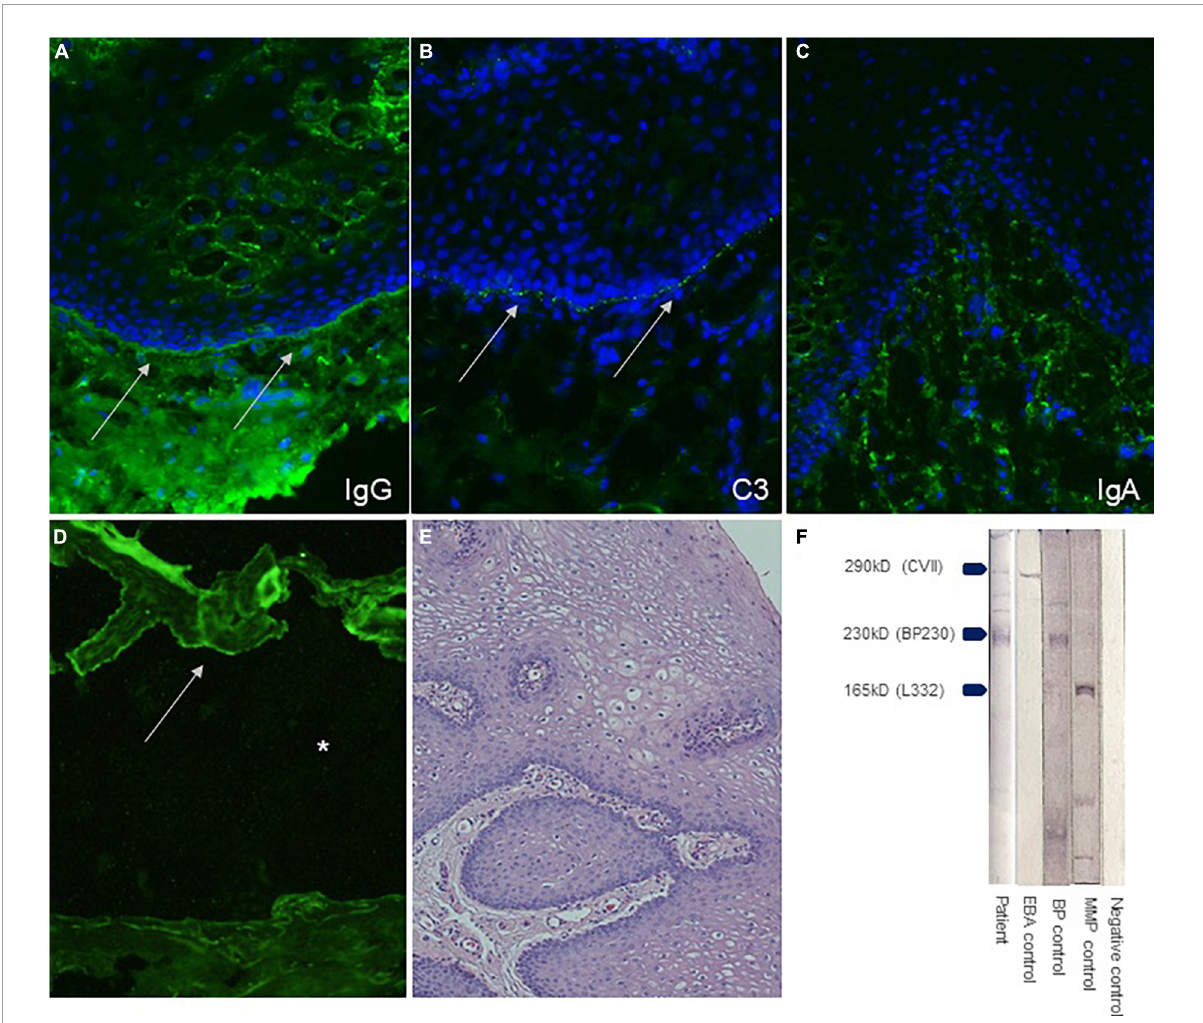
FIGURE2 Direct immunfluorescence (DIF) of buccal mucosa shows linear IgG and C3 depositions at basement membrane zone, each indicated by arrows (A,B) . DIF found no reactivity for IgA (C) . Indirect immunofluorescence on 1M split human skin using patient’s serum shows epidermal staining of IgG (D) . Histopathology of buccal mucosa of the patient (hematoxylin-eosin stain, 200x magnification) (E) . Immunoblot analysis revealed IgG autoantibodies against BP230 and slightly also against collagen VII (F)